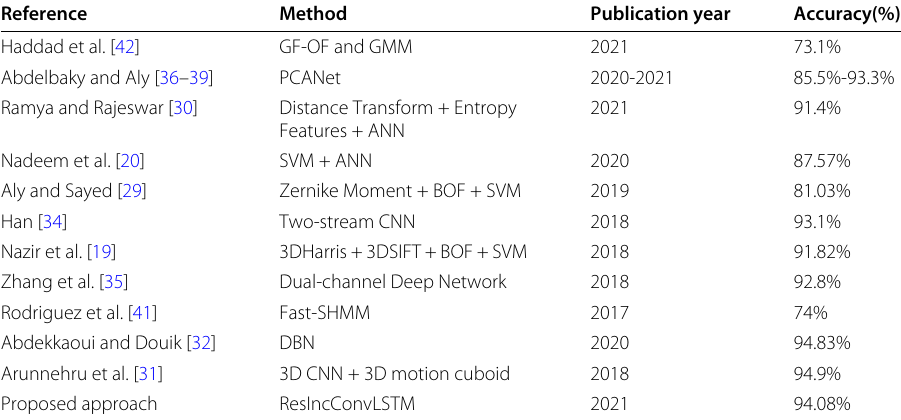
Table 6 Comparison with existing approaches on KTH dataset